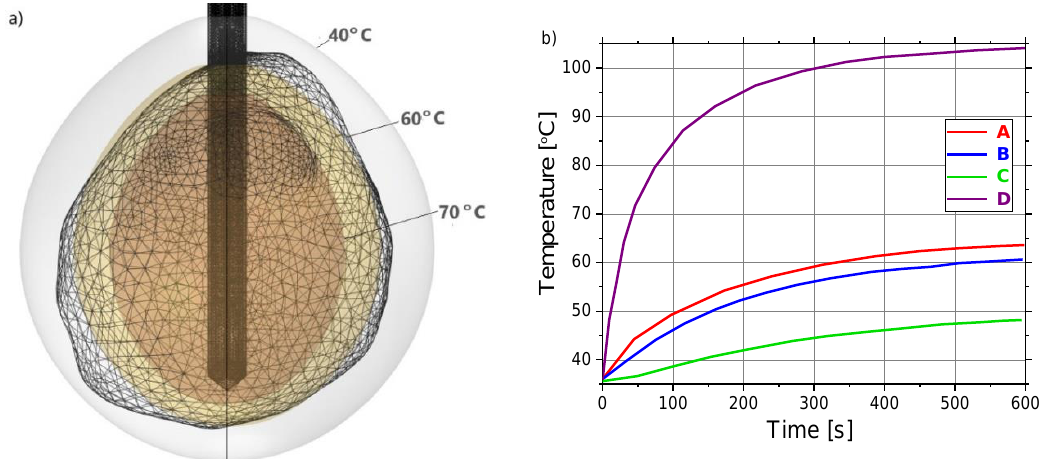
Figure 9. ( a ) Three-dimensional plot of the liver tumor [70] represented by triangulated surface and isocontours that correspond to the temperature of 40 °C (light gray), 60 °C (light brown), and 70 °C (brown). ( b ) The time dependence of the temperature calculated at test points (A, B, C, and D) is marked in Figure 4b.